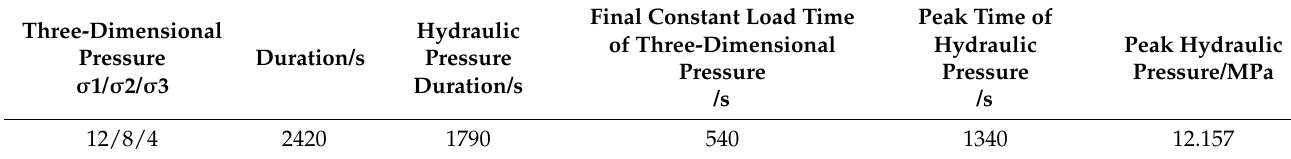
Figure 5. Waveform time–domain and frequency–domain diagram (( a ) original waveform diagram and ( b ) amplitude– frequency diagram).